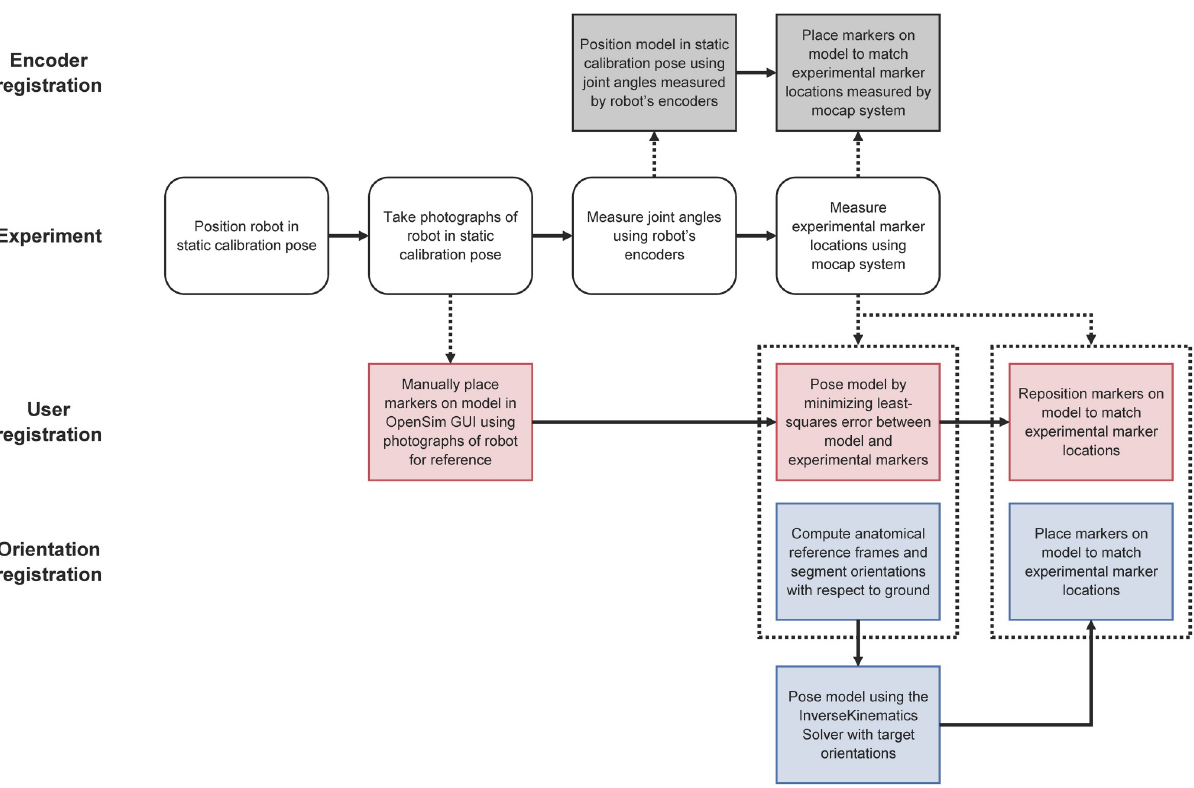
Fig 2. Marker registration methods examined in this study. Data collected during experiments (white boxes) were used in three registration methods: encoder registration (gray boxes), user registration (red boxes), and orientation registration (blue boxes). Solid arrows indicate the sequence in which processes occur; dotted arrows and boxes indicate the processes that use each type of experimental